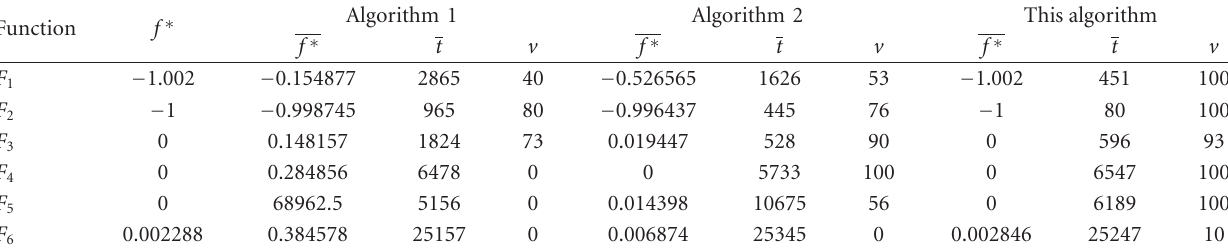
Table 1: Comparison of CAA and others.